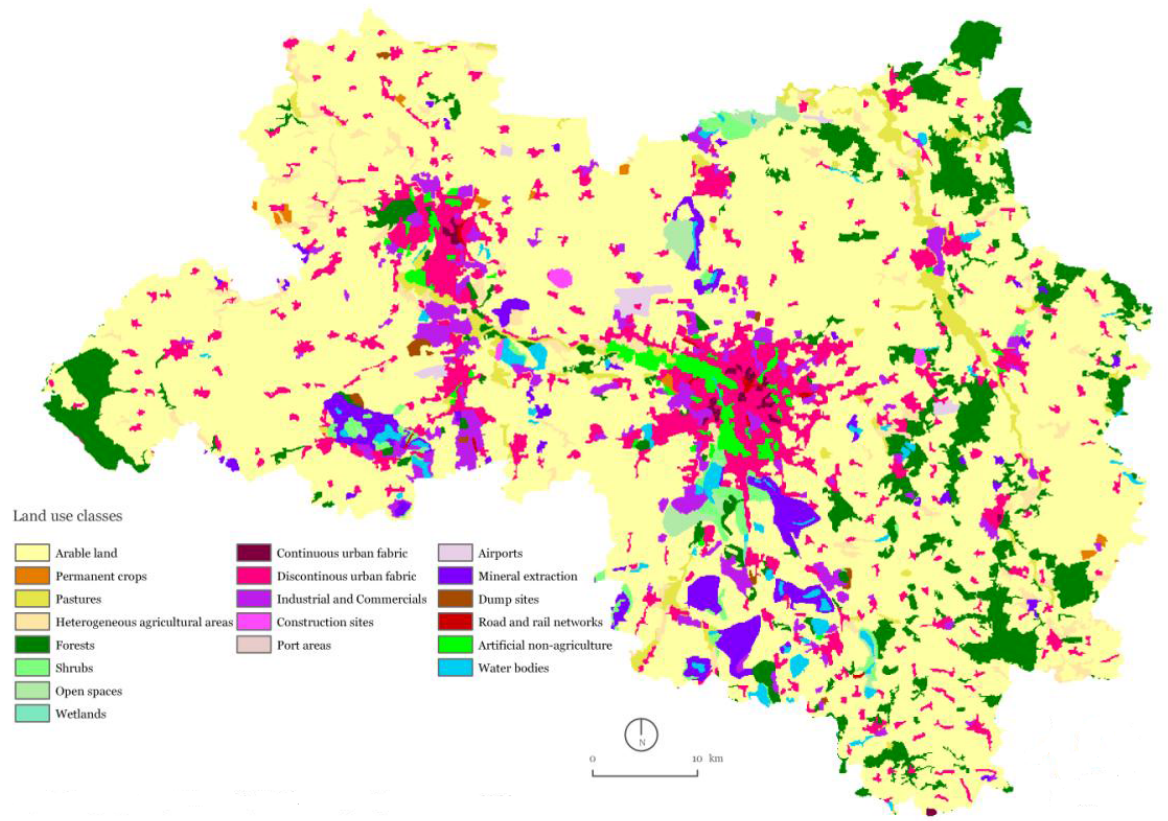
Figure 6. Leipzig 2025: Transport Scenario. which would contribute to a reduction in commuting